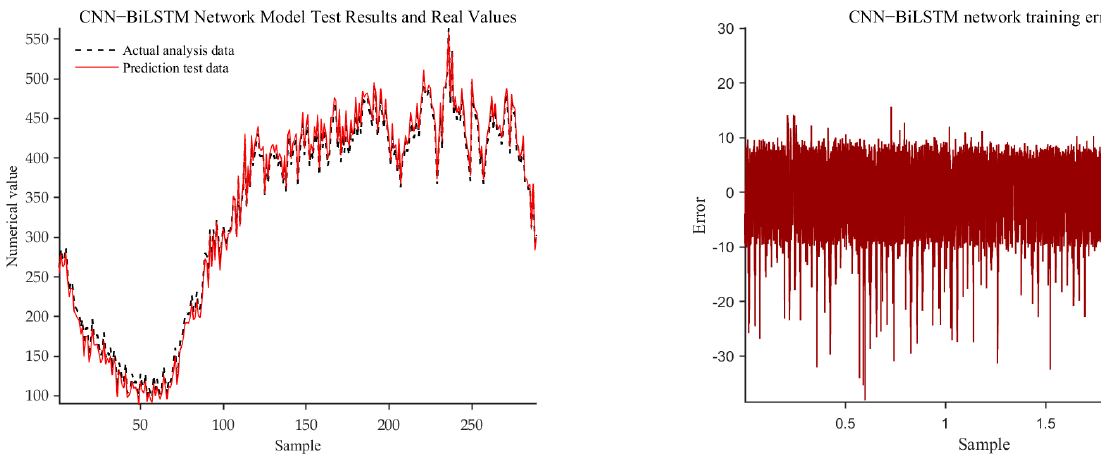
Figure 6. Forecast results and errors.